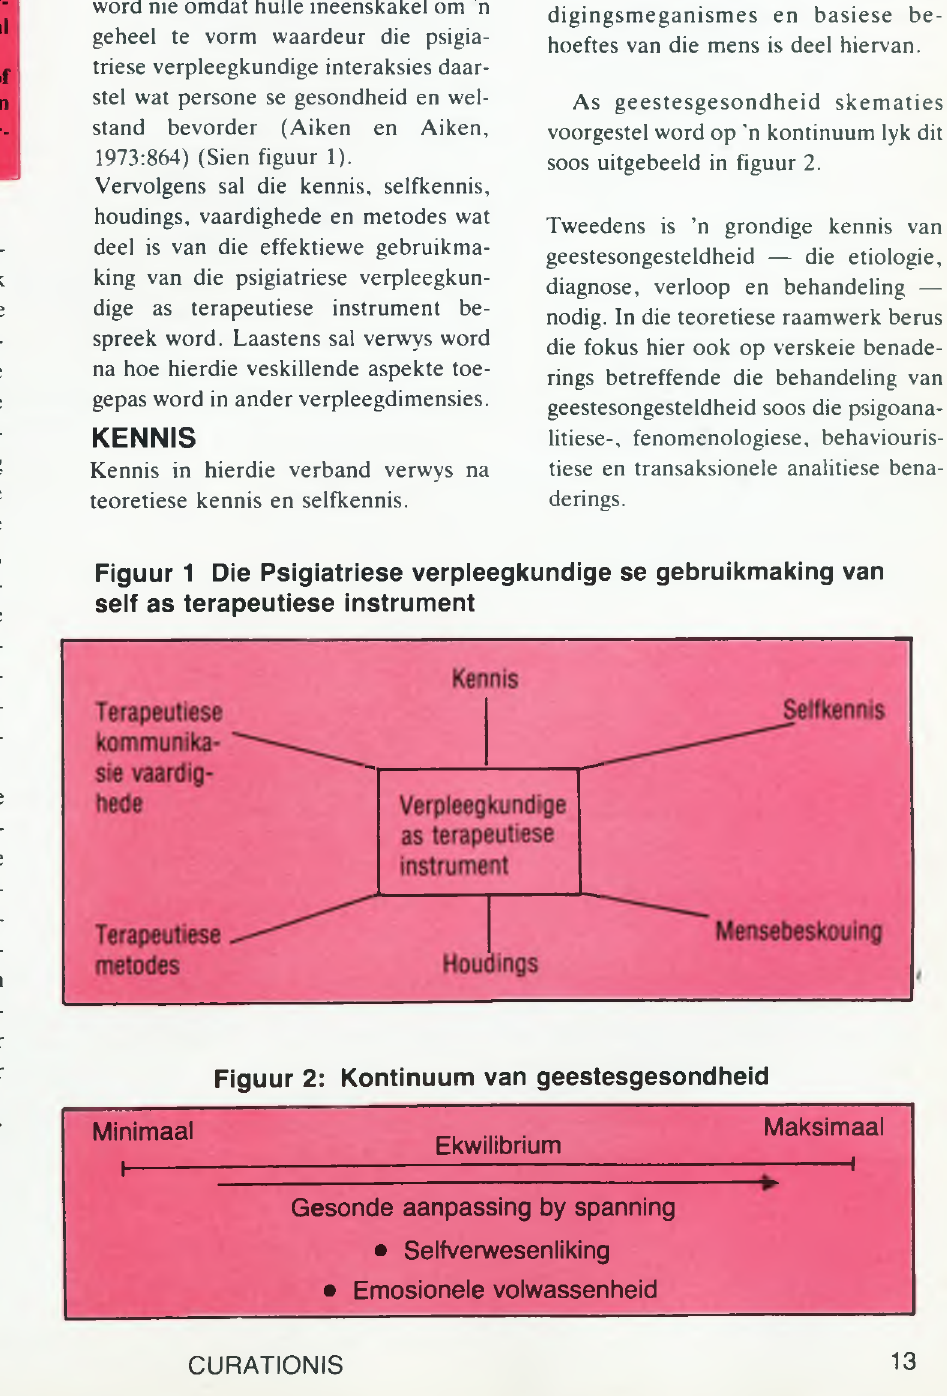
Figuur 2: Kontinuum van geestesgesondheid